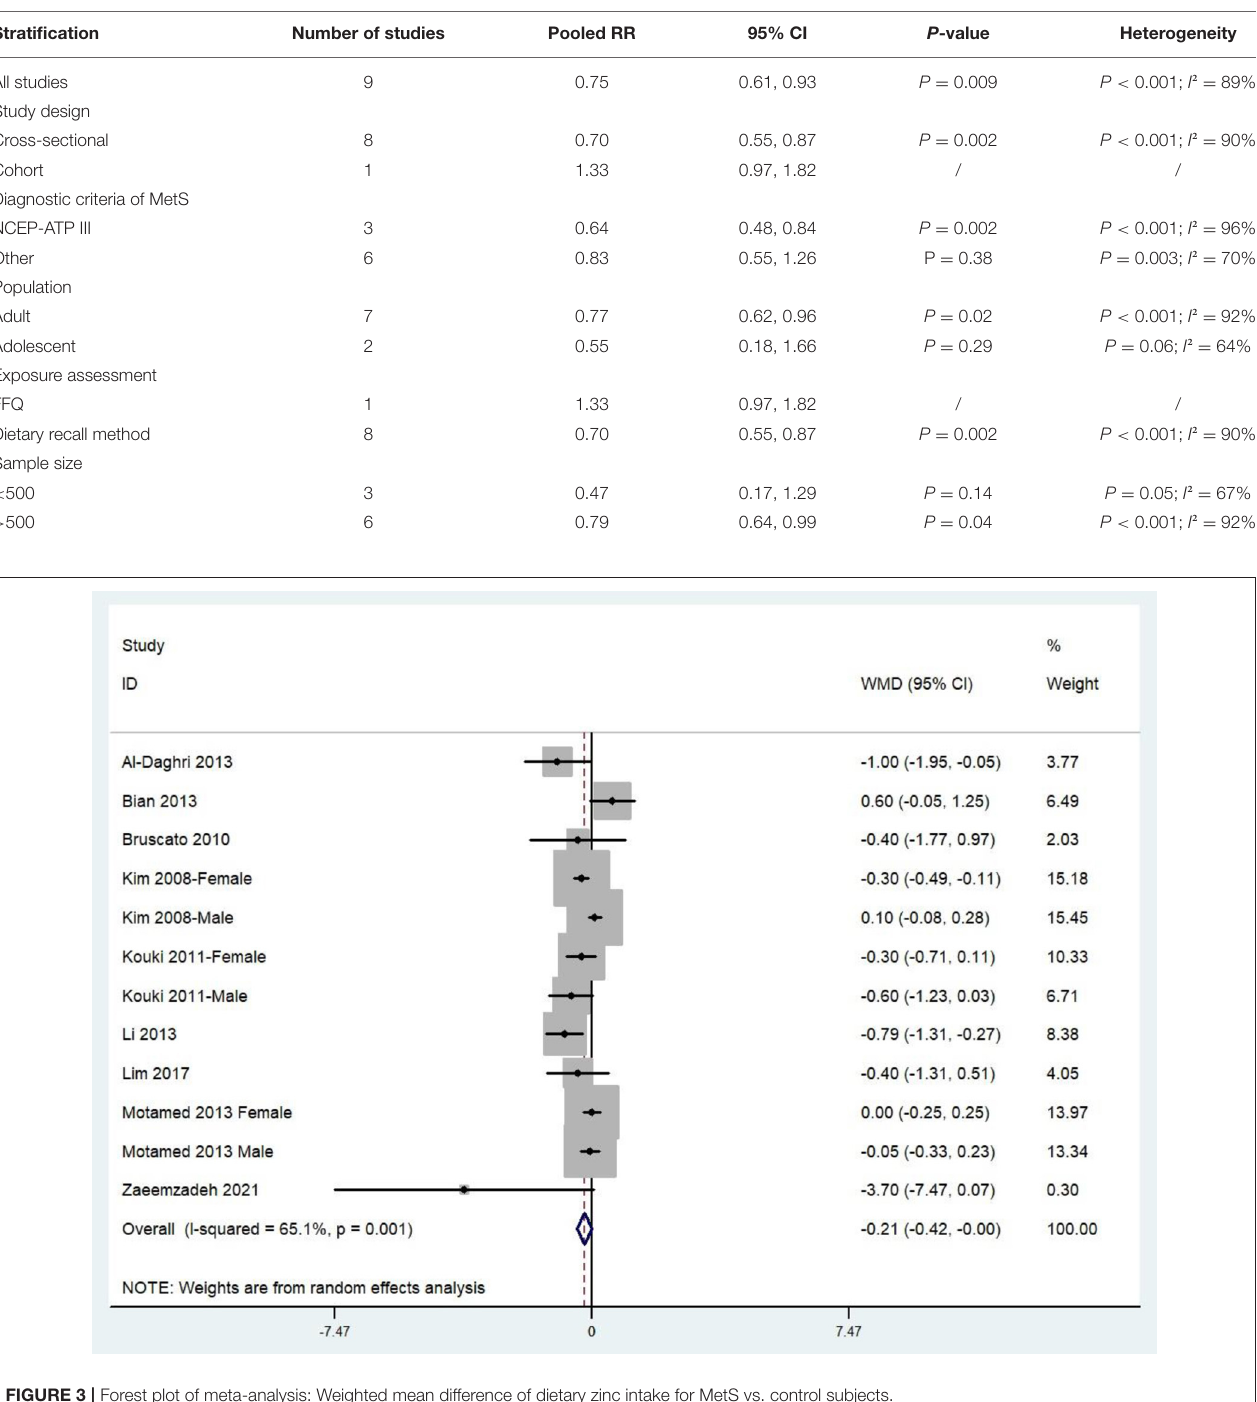
well-designed prospective cohort study with the specification of population age (adult/adolescent) is still